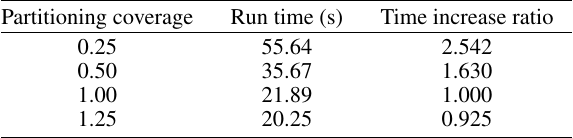
Table 4 Impact of partitioning coverage on real-world dataset.